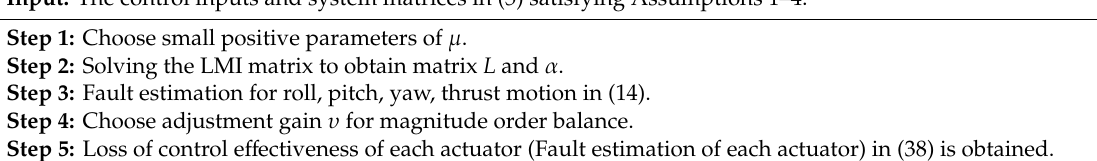
Table 1. Fault estimation procedure.